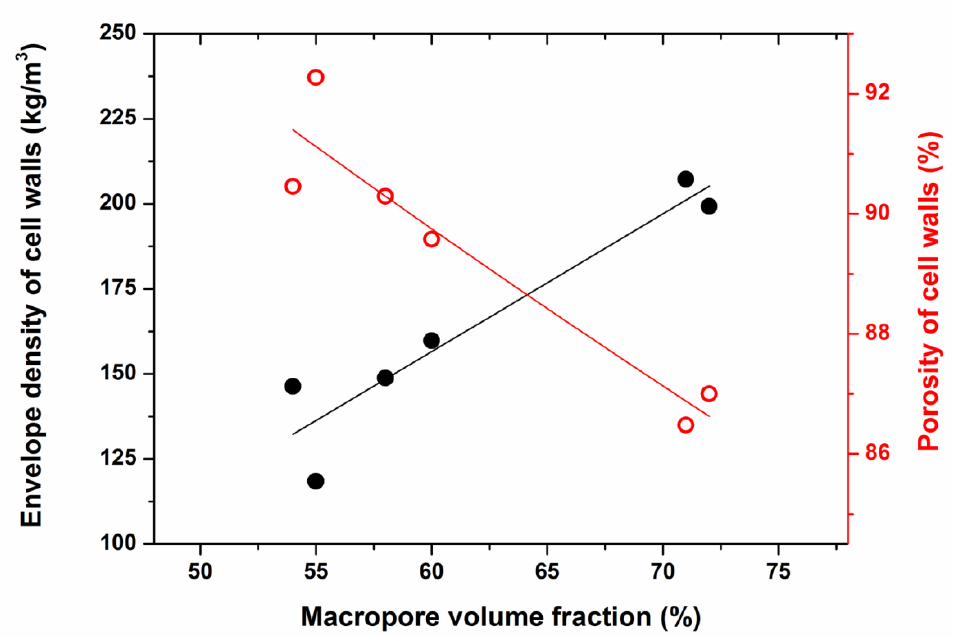
Figure 7. Envelope density of the cell walls (left axis) and their porosity (right axis) as it varied with the macropore volume fraction. The lines drawn in are guides for the eyes.